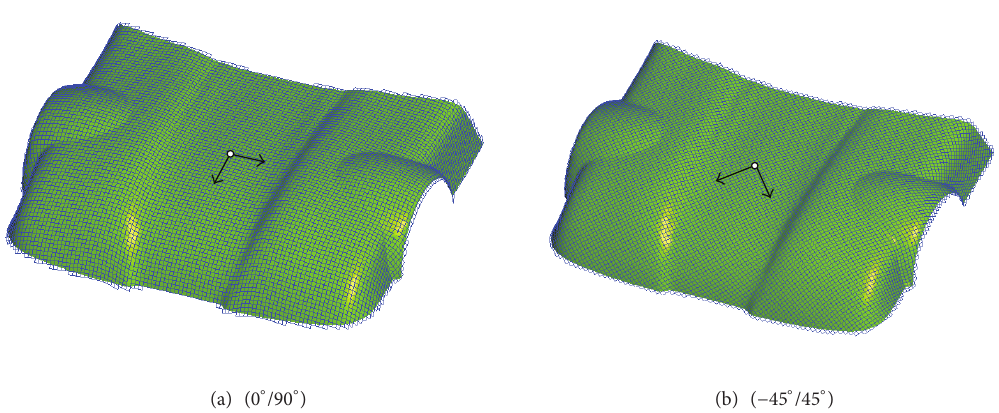
F 9: 3D geometrical draping of hood car part: (a) 0